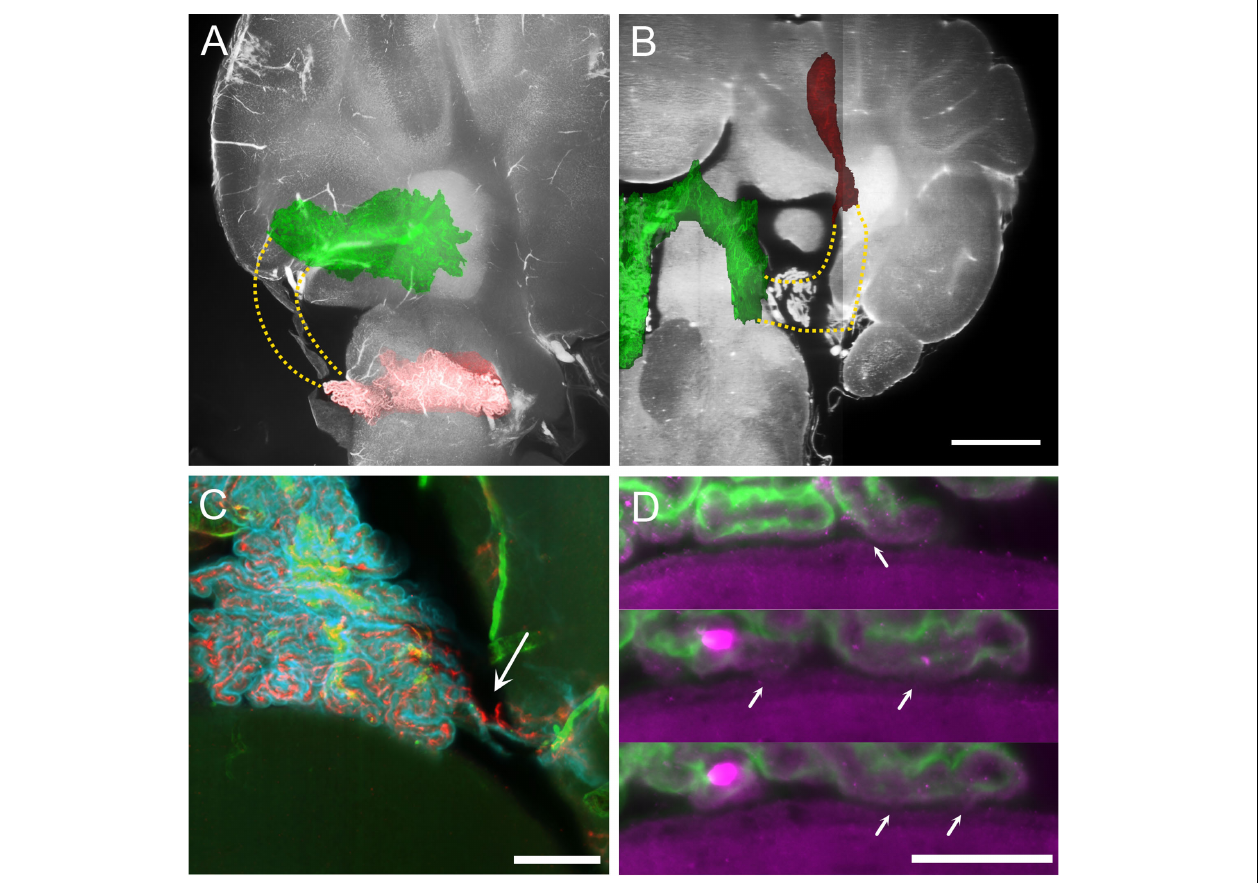
FIGURE 4 | MHS-LHS junction after removal of temporal bone. (A) Overlay of plexus vascular segmentation with a substack of unsegmented hindbrain. Red, LHS; green, SS and MHS. The stippled area in yellow corresponds to the location of the missing part of the CP. Sagittal view. (B) Similar to (A) , resliced to horizontal plane. Scale bar: 1 mm. (C) COLM image of a contact region between CP and DCN in a sample where temporal bone has been removed. The plexus appears ripped (arrow) but contact with DCN is not removed. Scale bar: 200 µ m. (D) Magnification of the CP-DCN contact (same animal as in C ) showing the indentation marks left by CP villi on DCN ependymal surface. In some positions (arrows) the CP appears connected to the DCN surface. Scale bar: 100 µ